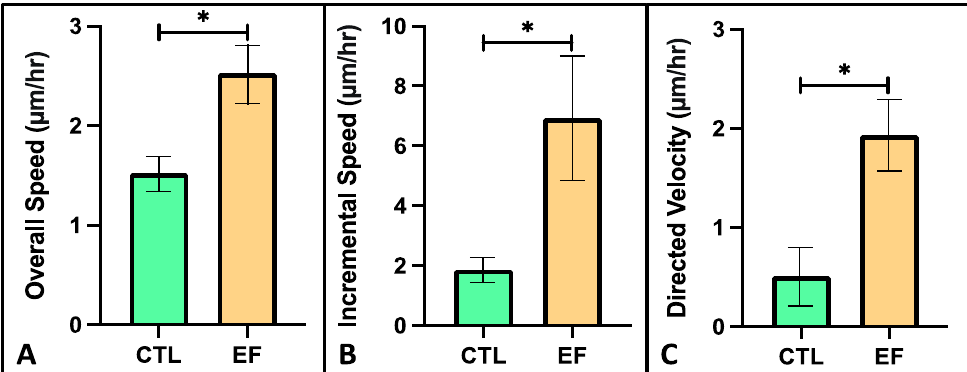
Figure 6. Effect of DC EFs on ( A ) overall speed, ( B ) incremental speed, and ( C ) directed velocity of bovine FLS within a 3D collagen hydrogel (* p < 0.001). Parameters were determined by following the path of individual cells for both CTL ( n = 20 cells) and EF treated ( n = 24 cells) groups.